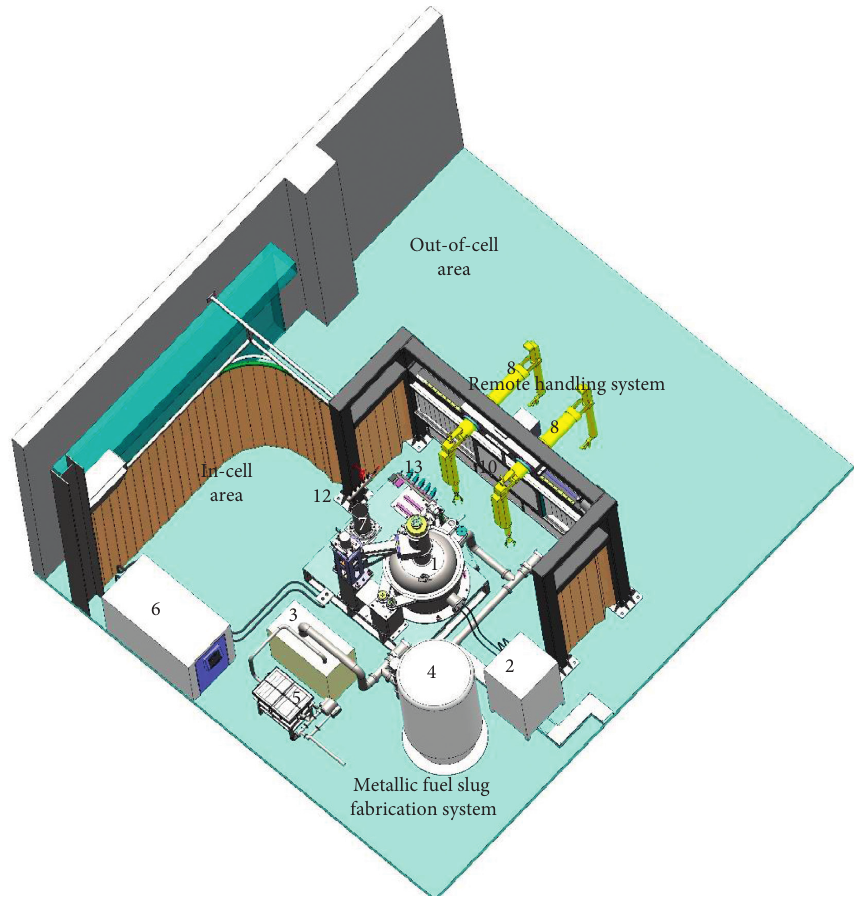
Figure 1: Full-scale graphical model of